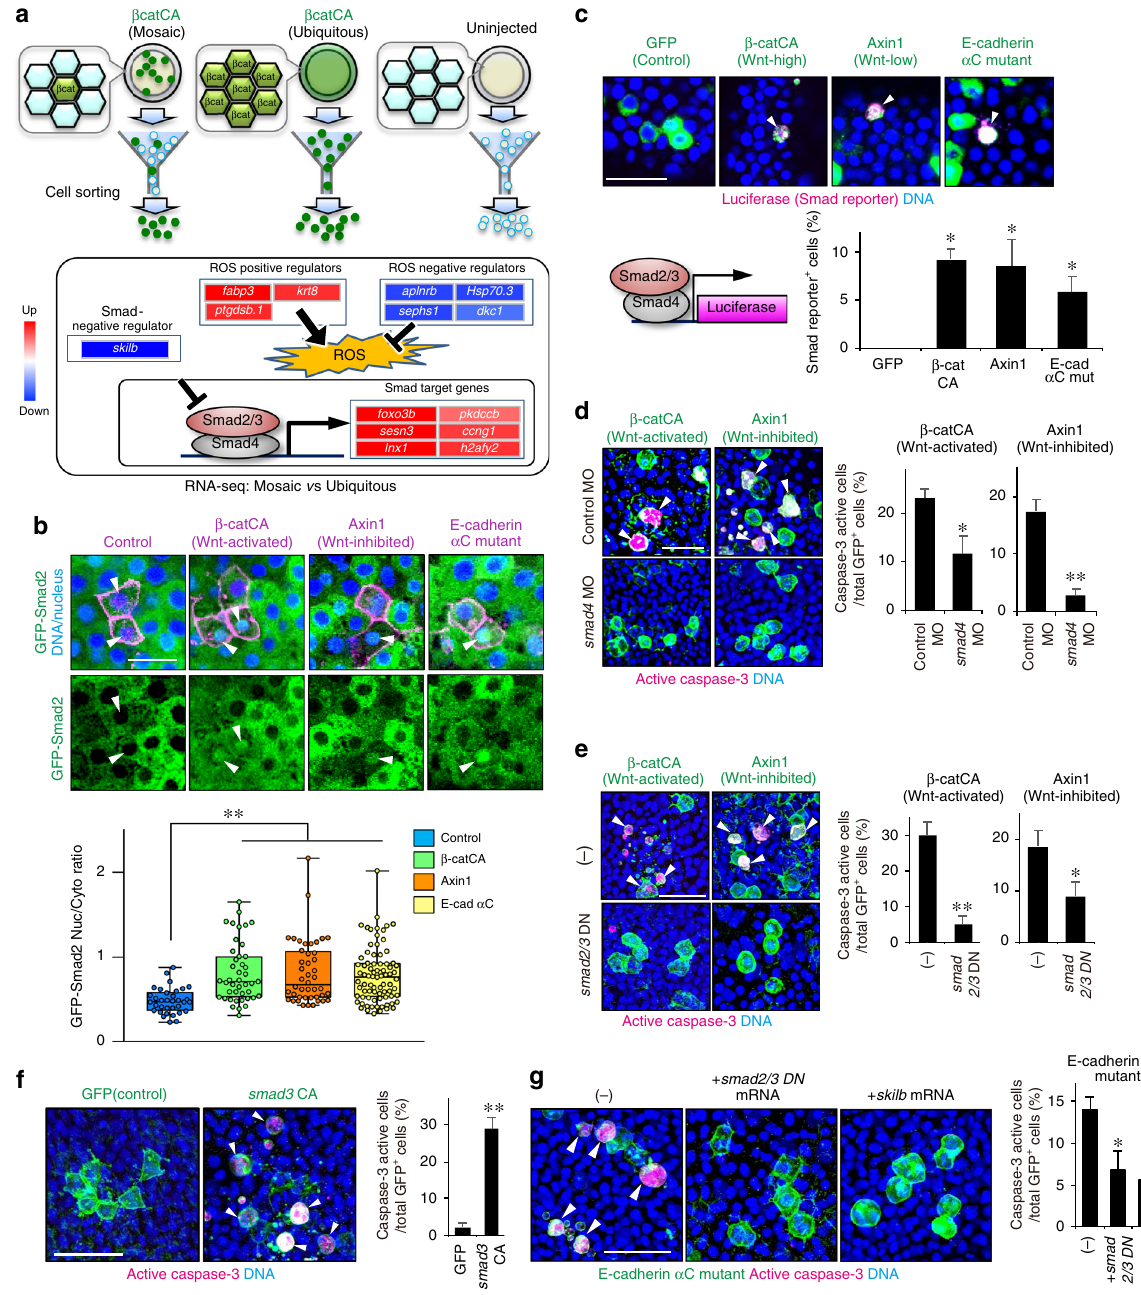
However, the detailed mechanisms by which cadherin-imbalance activates TGF- β -type Smads require further investigation. The Wnt/ β -catenin-noise cancelling system may act context- dependently because cell clones with abnormally high Wnt/ β - catenin activity can kill surrounding normal cells in Drosophila epithelial tissue (wing disc) 51 , whereas Wnt/ β -catenin activity- aberrant keratinocytes survive and persist in zebra fi sh larval skin. Clone size, cell/tissue-type, and/or intra-tissue localization might affect un fi t cell behaviour. We consider that the Wnt/ β -catenin- noise cancelling system acts in proliferative tissues that form a Wnt/ β -catenin-gradient and kills suddenly introduced single un fi t cells that produce excess noise in the gradient. Therefore, this system might also function in the intestinal crypt, which under- goes active cell turnover and also forms a Wnt/ β -catenin-gra- dient 52 . Accordingly, in mouse intestine, mosaically